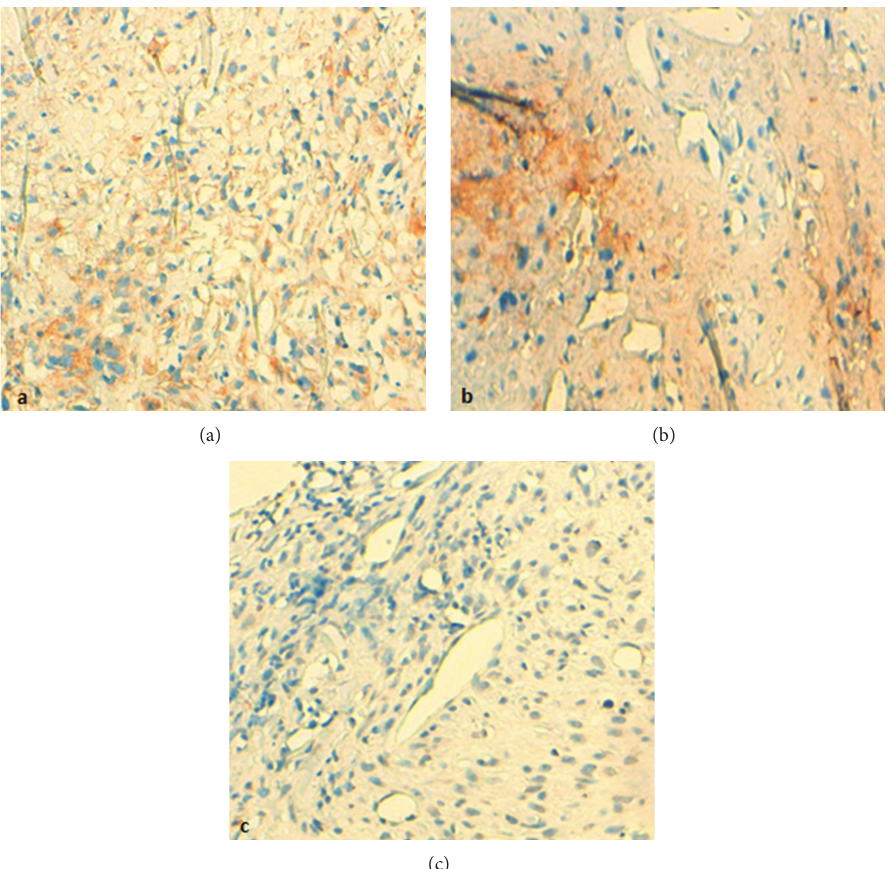
Figure 3: (a), (b) Immunochemistry positivity for desmin and H-caldesmon, respectively. (c) Negative immunohistochemical reactivity for cytokeratin.